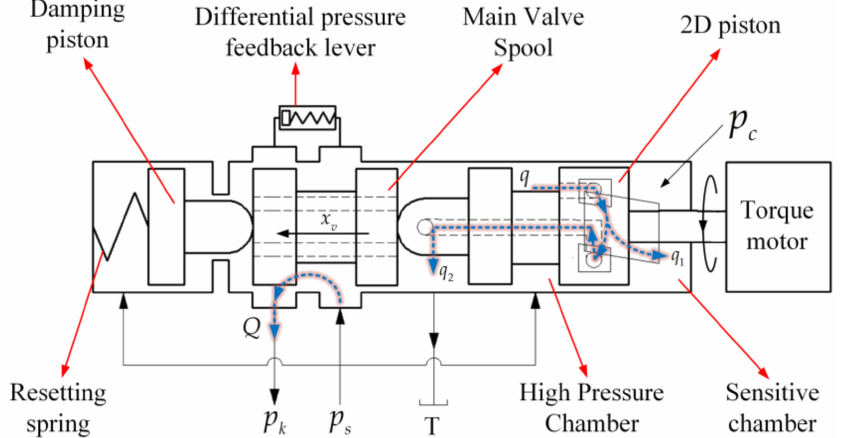
Figure 5. Structure principle of the 2D electric feedback flow regulating